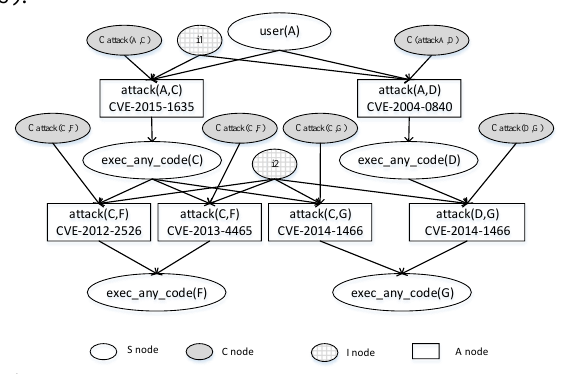
Fig. 3. Probabilistic attack graph